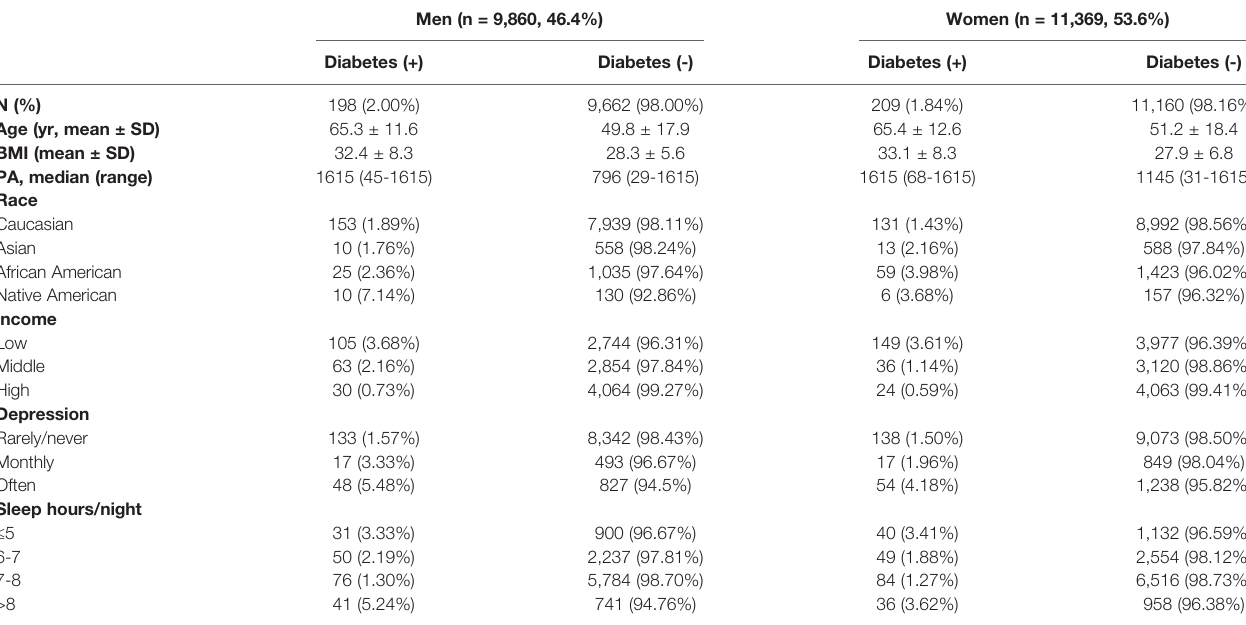
TABLE 1 | Demographic and clinical characteristics of the sample.